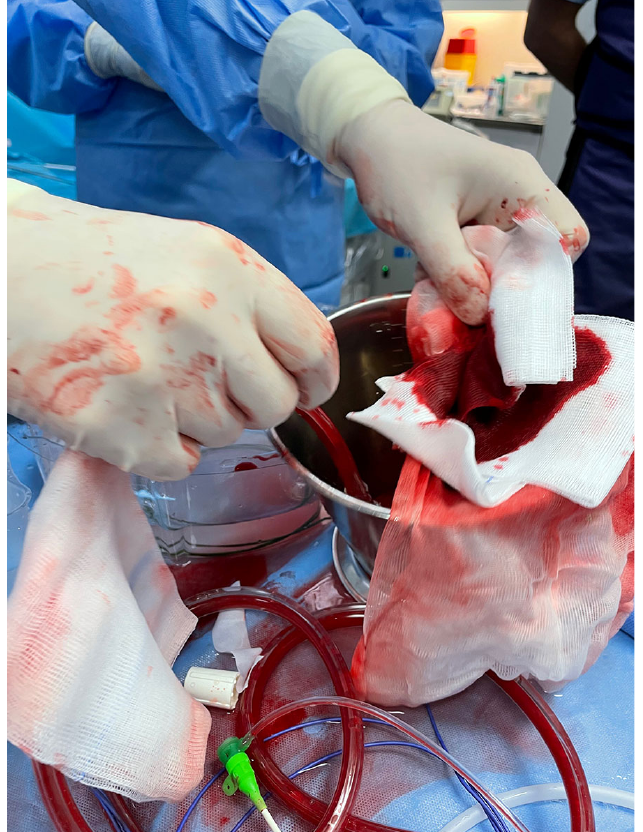
Figure 6. The removed blood during the aspiration procedure is filtered through gauze and collected in a cup. The collected fluid is then transferred into the Cell Saver ® to be processed for autotransfusion.